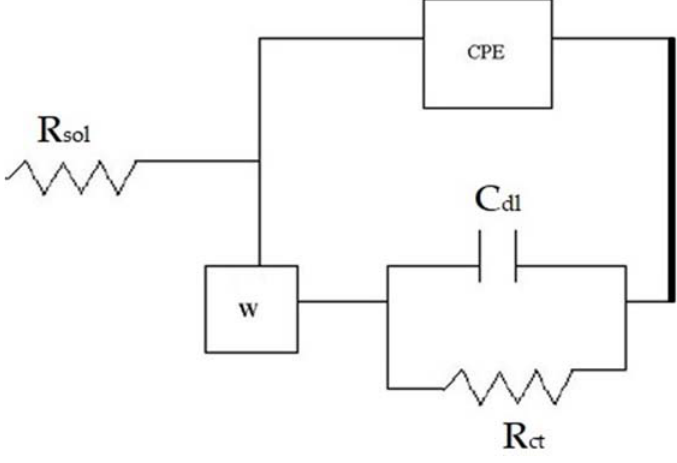
Figure 9. Equivalent circuit depicting the corrosion of 1us.